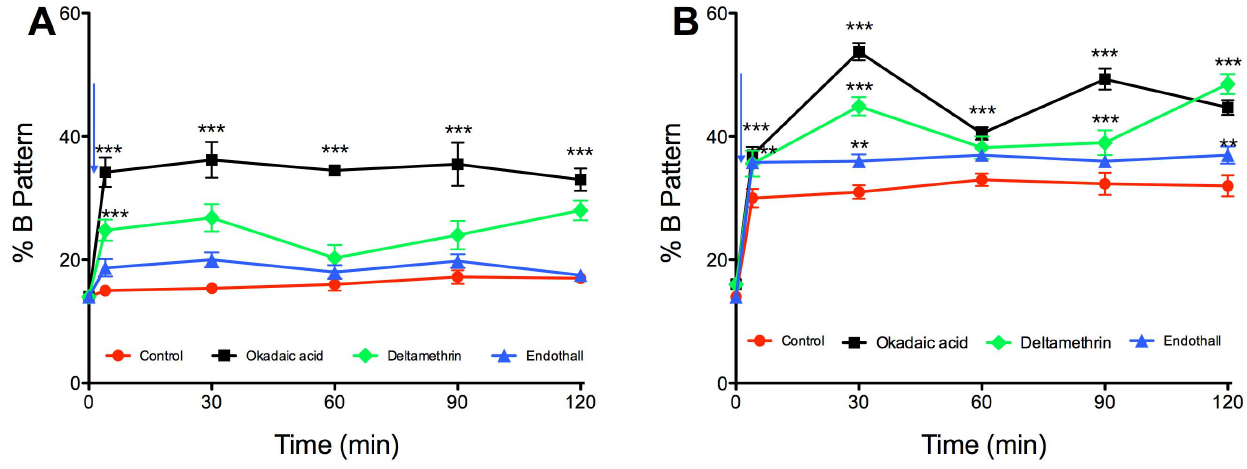
Figure 3. Effect of protein phosphatase inhibitors on human sperm capacitation. Human sperm were incubated in NCM (A) or RCM (B) for 120 min, and the capacitation pattern was evaluated using the CTC assay, as described in the Materials and Methods. The inhibitors used were okadaic acid (black squares), deltamethrin (green diamonds), and endothall (blue triangles). Results were obtained from five different donors and were expressed as the mean 6 SEM of the percentage of B pattern. The arrow indicates the addition of BSA and bicarbonate. * p , 0.05; ** p , 0.005; *** p , 0.001.